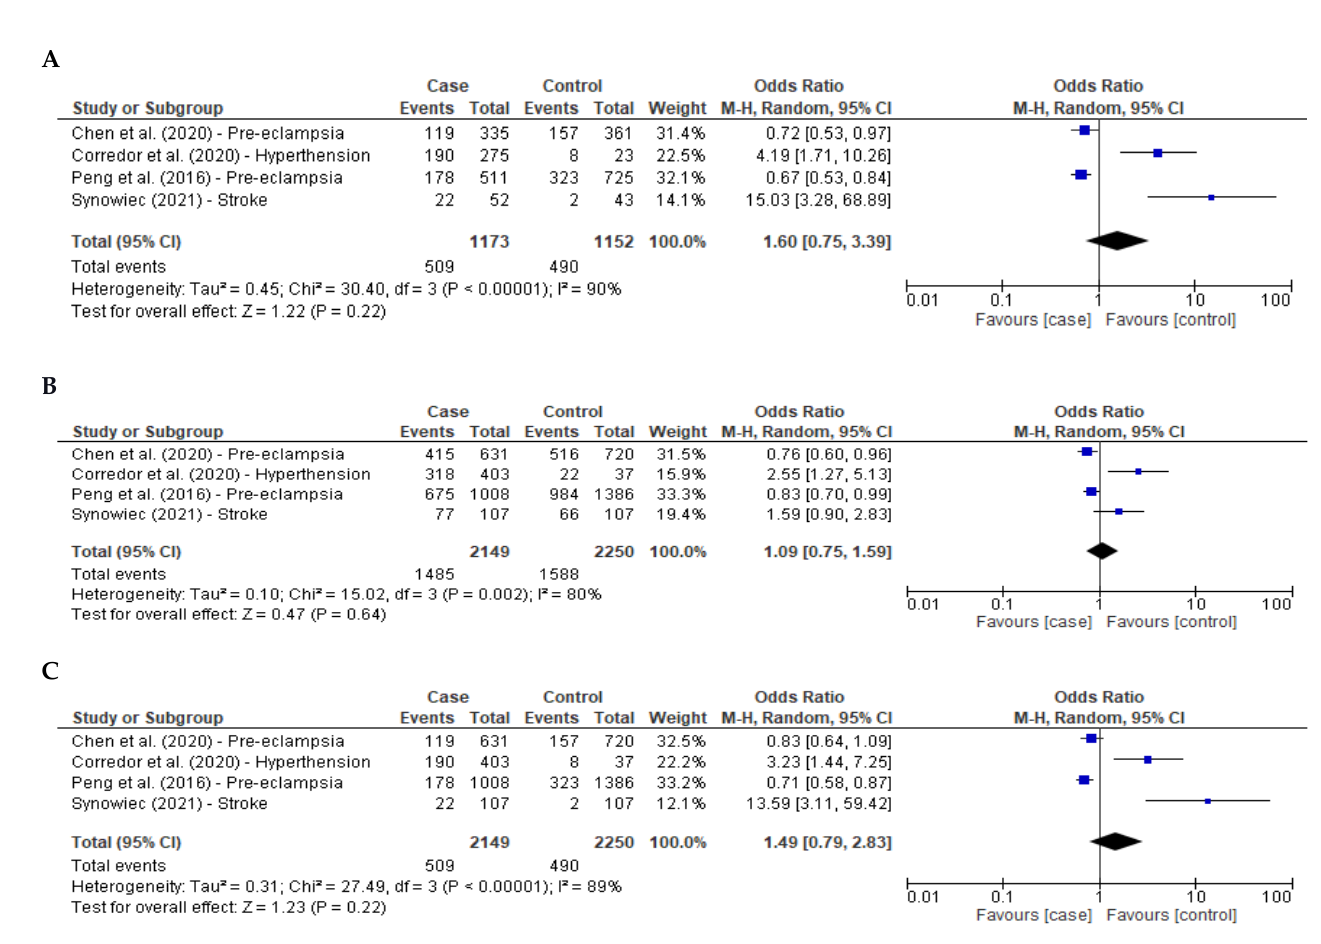
Figure 3. Forest plots of odds ratios with 95% confidence intervals of the association between GPX4 (rs713041) SNP and risk of hypertension-related diseases. ( A ) — Additive model (TT vs. CC) [38 – 41], (rs713041) SNP and risk of hypertension-related diseases. ( A )—Additive model (TT vs. CC) [38–41], ( B ) — Dominant model (CT+TT vs. CC) [38 – 41] and ( C ) — Recessive model (TT vs. CC+CT) [38 – 41]. ( B )—Dominant model (CT+TT vs. CC) [38–41] and ( C )—Recessive model (TT vs. CC+CT)